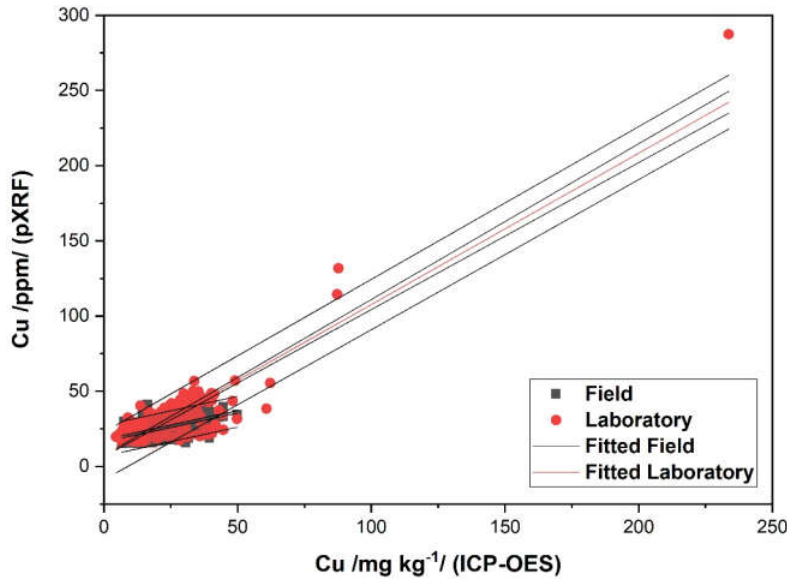
Figure 2. Statistical significance of regression model for Copper (pXRF) in soil samples from experimental soil sites from Otava and Mže river basins, measured in FIELD and LABORATORY.